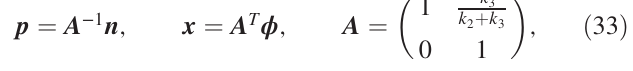
FIG. 9. Capacitively-shunted SNAIL with N ¼ 2 large Joseph- son junctions. The external magnetic flux Φ pierces the loop formed by the Josephson